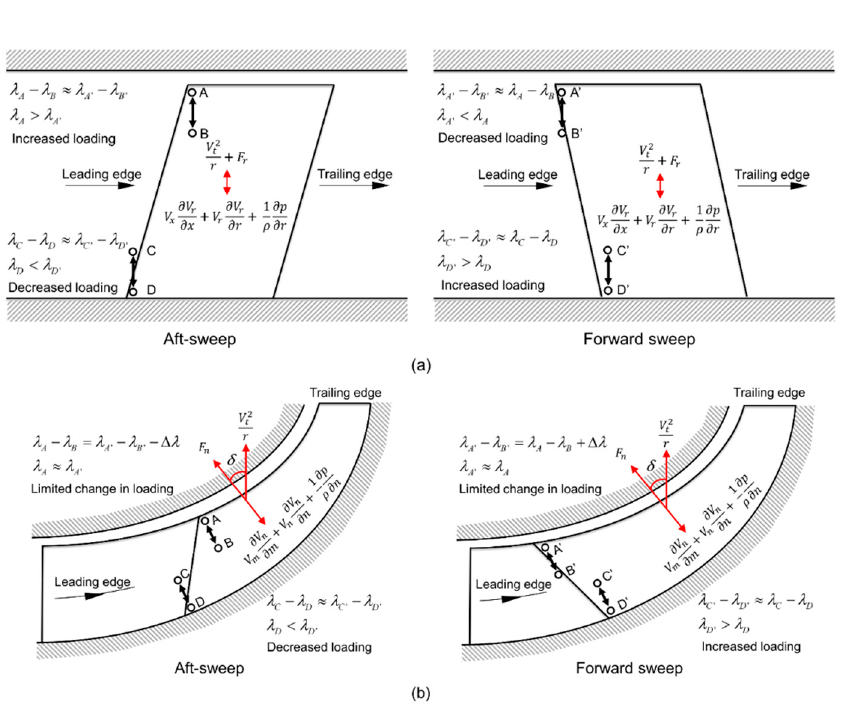
Figure 17. Understanding sweep effects on the front loading of ( a ) axial compressors and ( b ) centrifugal compressors through loading definition.